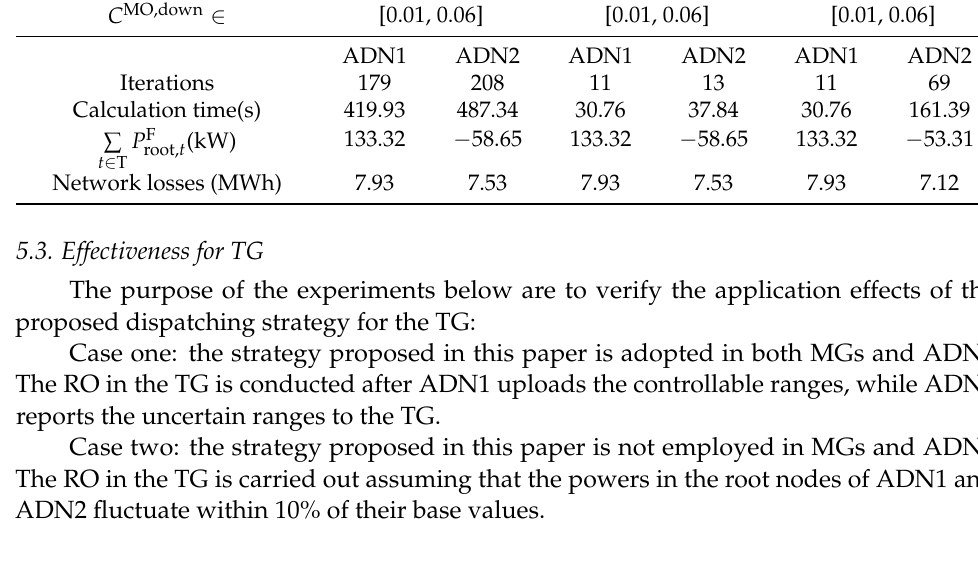
Price Ranges for